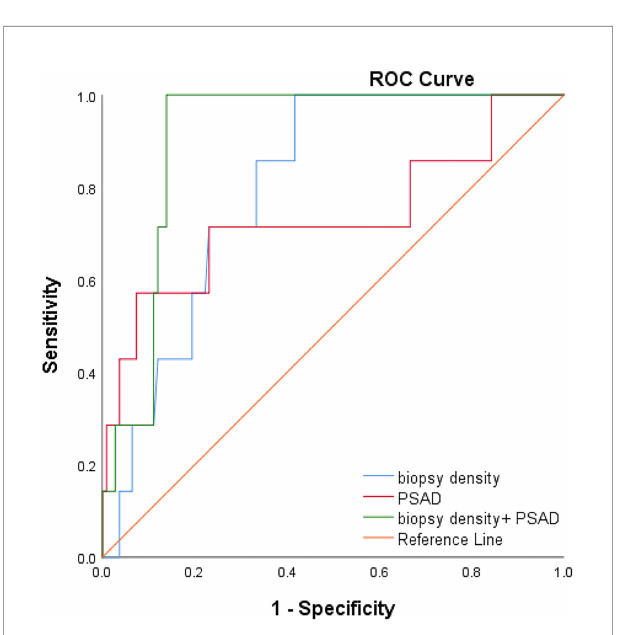
FIGURE 5 | ROC curve of csPCa using PSAD, BD and